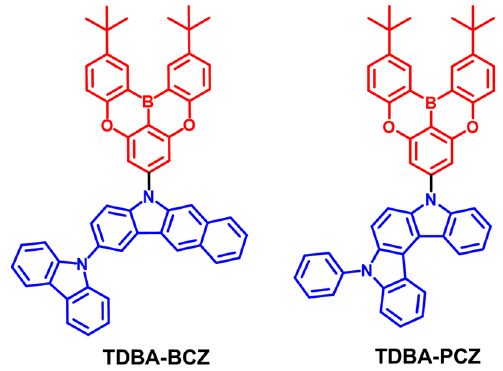
Figure 1. Molecular structures of the synthesized emitters with bipolar properties: TDBA-BCZ and TDBA-PCZ.